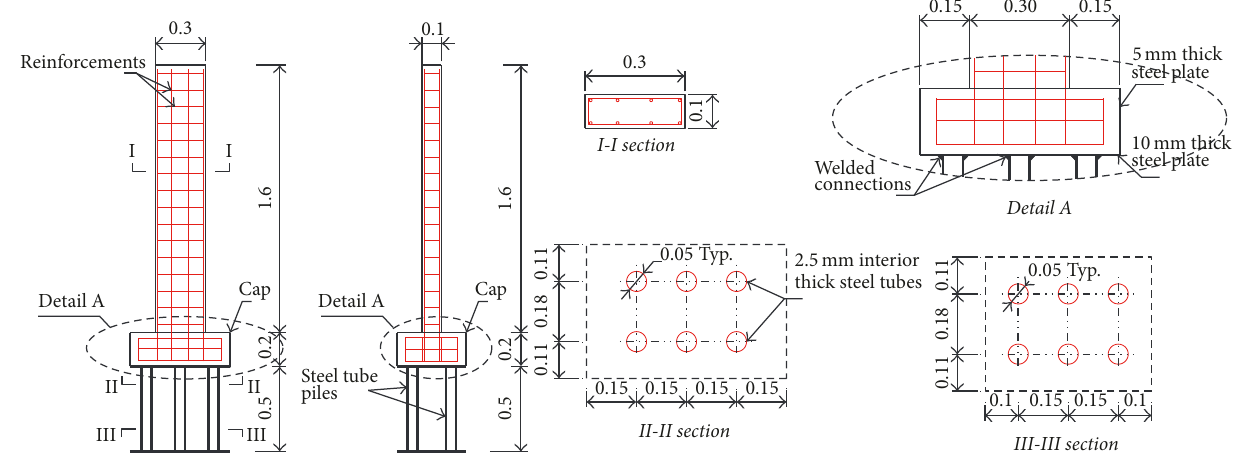
Figure 4: Dimensions and details of the pier specimen; all dimensions are in meters unless otherwise specified.